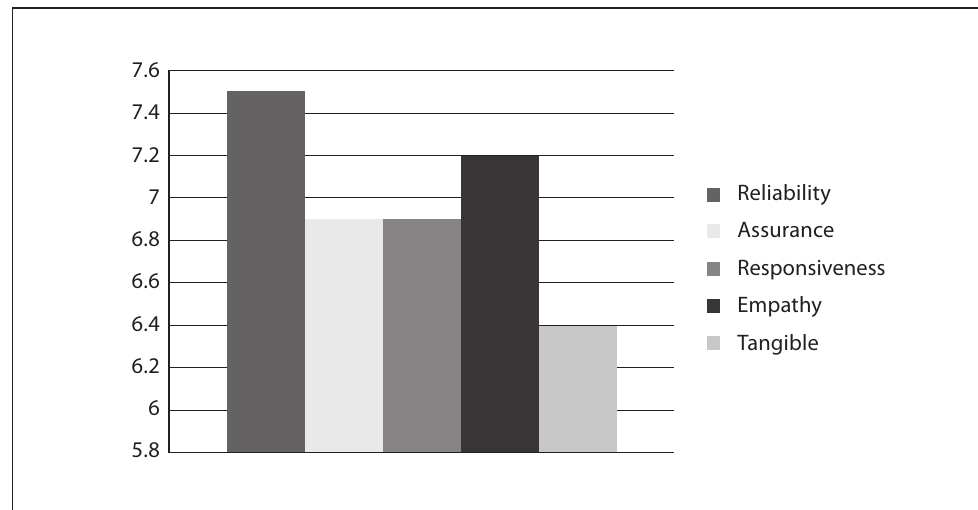
Figure 2 Mean service quality scores of the service dimensions in the online